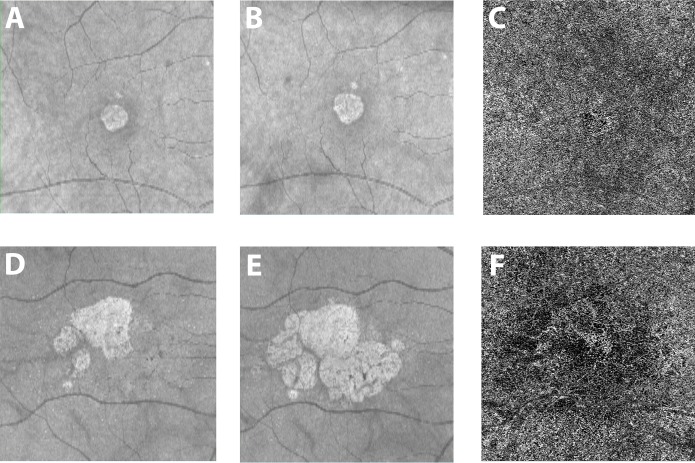
Examples of eyes with geographic atrophy and different growth rate.One eye from two patients with geographic atrophy (GA) are shown in the two rows of images. A and D are the optical coherence tomography (OCT) fundus photos at baseline while B and E were acquired after one year. The two patients show a very different yearly growth rate (0.07 and 0.73 for the first and second row respectively). The OCT angiogram at the level of the choriocapillaris (C and F) from the baseline visit for these two patients shows dramatically different flow impairment surrounding the lesion, with considerably greater flow voids in the latter case (41,2% versus 53% for the first and second row respectively).